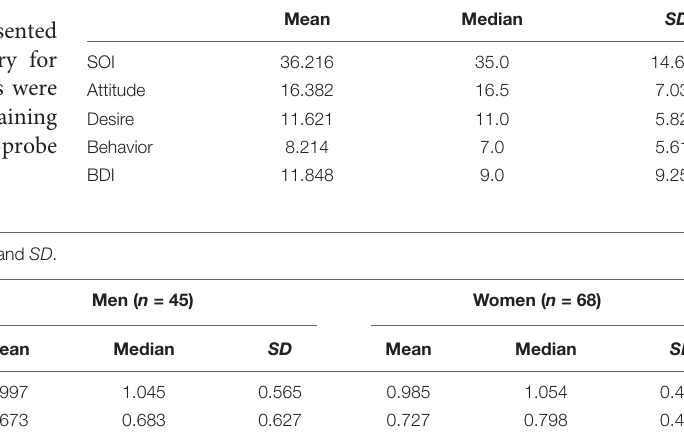
TABLE 6 | Questionnaires: Mean, median, and SD .